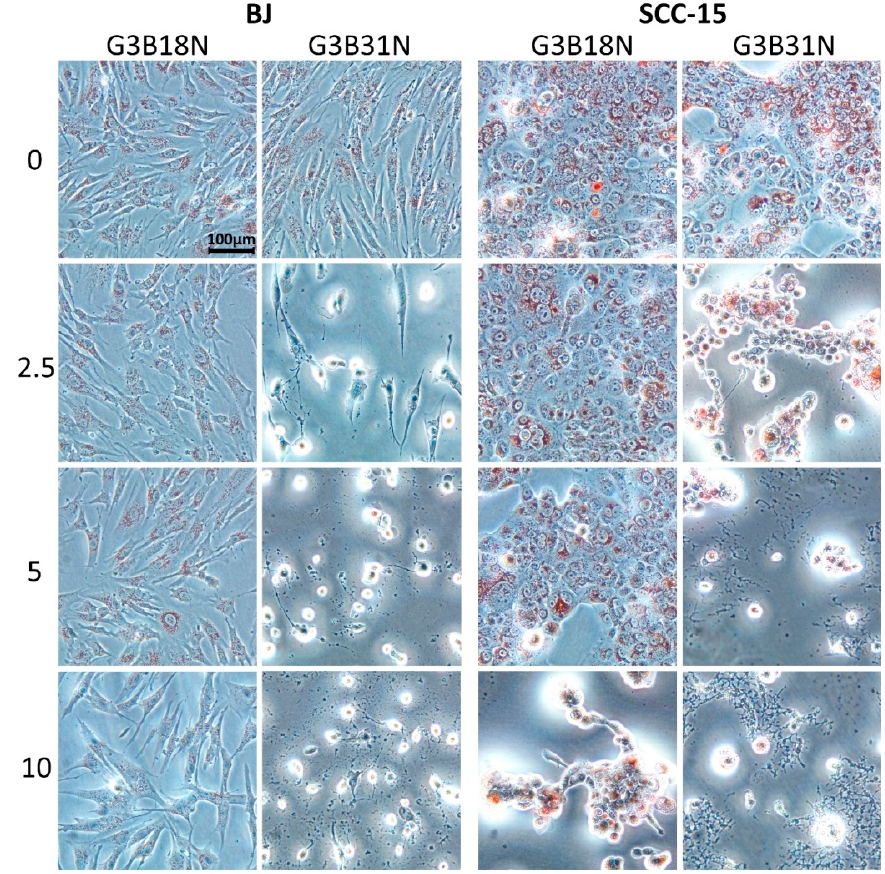
Figure 3. Morphology of BJ and SCC-15 cells after 24 h treatment with G3 B18N or G3 B31N as estimated with neutral red (NR) assay. Numbers indicate concentration ( µ M) of bioconjugates, red signal display the lysosomal NR accumulation in treated